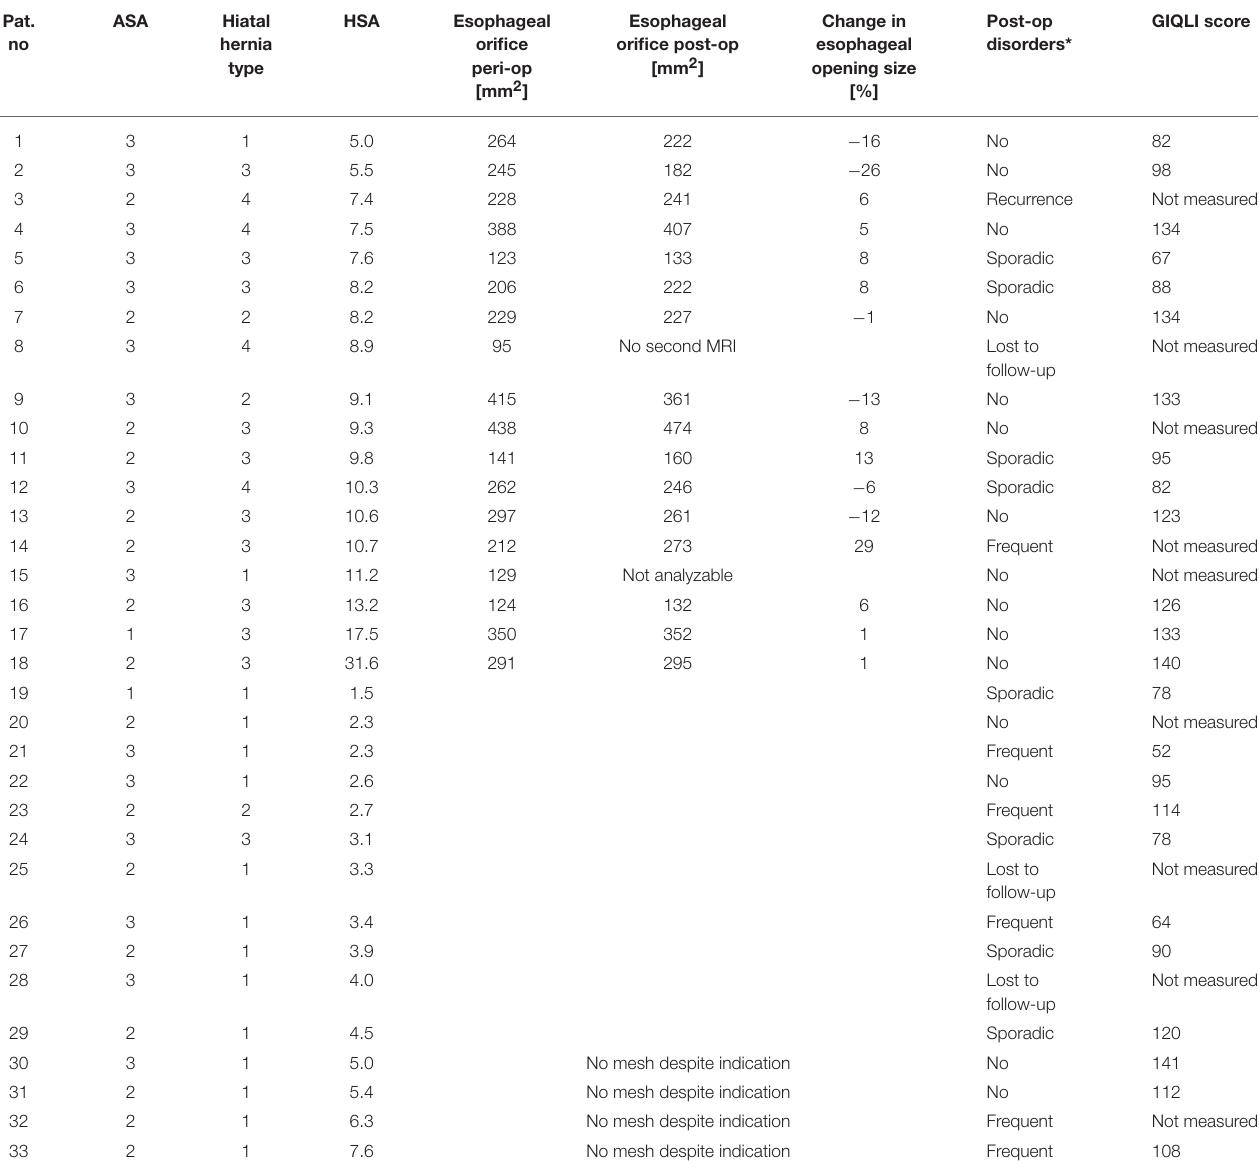
TABLE 1 | Patient charactersitics of all patients with and without mesh augmentation. Pat. no